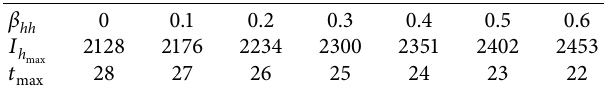
Table 2: Influence of the host-to-host transmission rate β maximum proportion of infected individuals in the host population I t . h max at time max